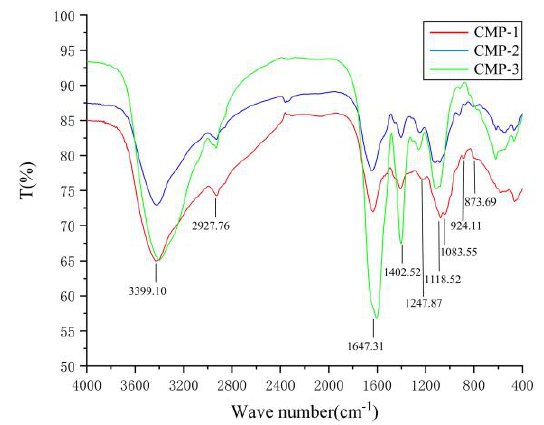
Figure 5. The FT-IR spectrum of CMP-1, CMP-2 and CMP-3. was obtained by the second derivative of infrared spectrum, which proved that CMP-1, CMP-2 and CMP-3 were of significant difference in the fingerprint region (800 ~ 1300 cm − 1 ) (Figure 6a). In detail, CMP-1 has three weak absorption peaks (1109 cm − 1 , 1125 cm − 1 , 1151 cm − 1 ) in the range of 1110 ~ 1160 cm − 1 , which may be attributed to side chains on α -carb \ zon. Compared with CMP-1, however, there was no obvious absorption peak at 1125 cm − 1 in CMP-2 and 1150 cm − 1 in CMP-3, under the condition of neglecting the weak wave number shift caused by the tolerance error. The same situation was evident within the range of 990~860 cm −1 ; CMP-3 had six absorption peaks, while CMP-1 had only three